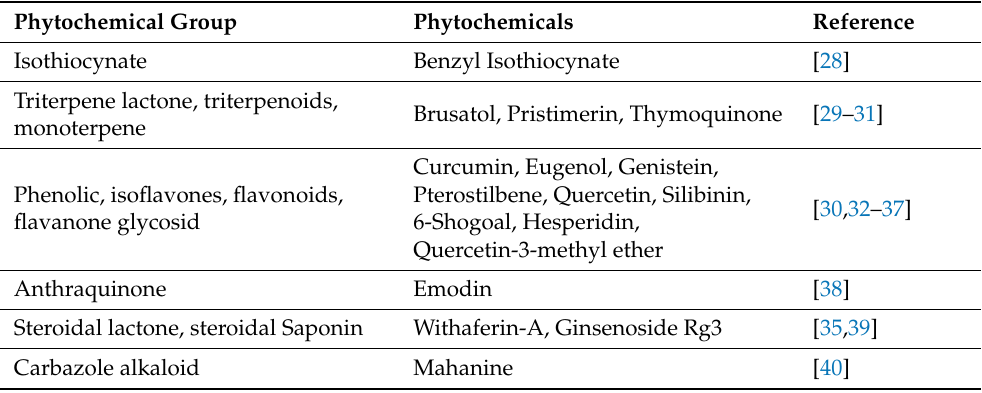
Table 1. List of dietary phytochemicals and associated secondary metabolite group targeting luminal A breast cancer